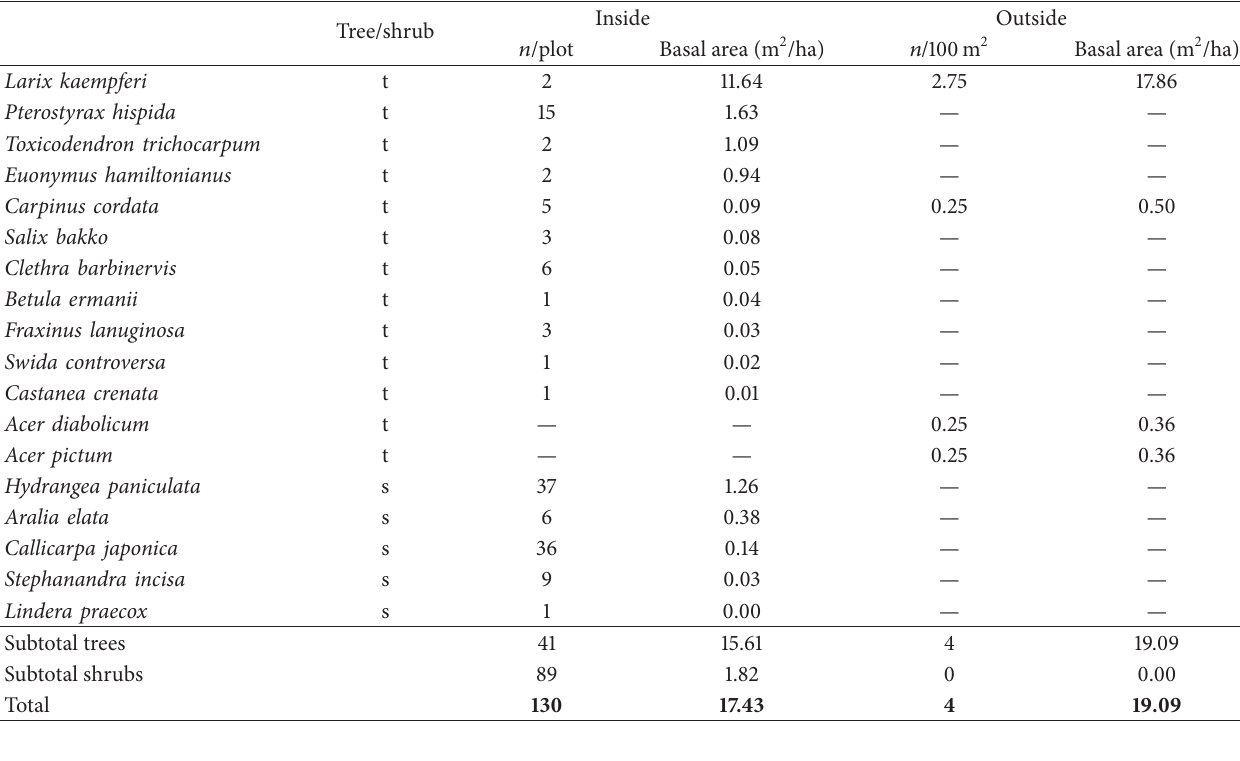
Table 1: Densities and basal area of trees and shrubs appearing in 10m × 10m plot inside and 20 m × 20 m plot outside the exclosure at Okutama, western Tokyo, Japan.